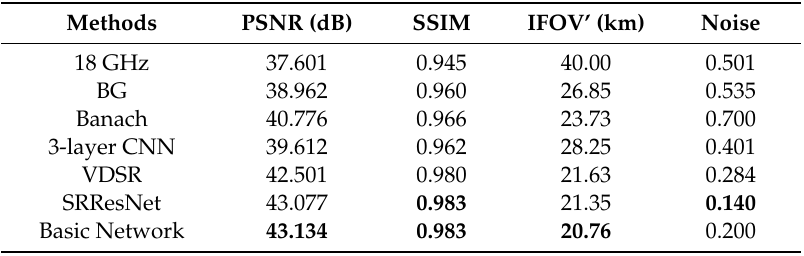
Figure 8. The along-track transects of the synthetic scenario. ( a ) The along-track transects around the strip (labeled with the blue dash-dotted line in Figure 7i); ( b ) The along-track transects around the background (labeled with the red dash-dotted line in Figure 7i). Table 2. The averaged evaluation indexes of the synthetic scenario.